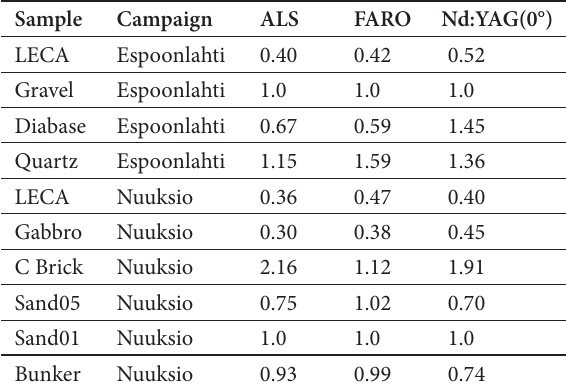
Table. Measurements from Espoonlahti and Nuuksio, compared with laboratory measurements (FARO TLS and